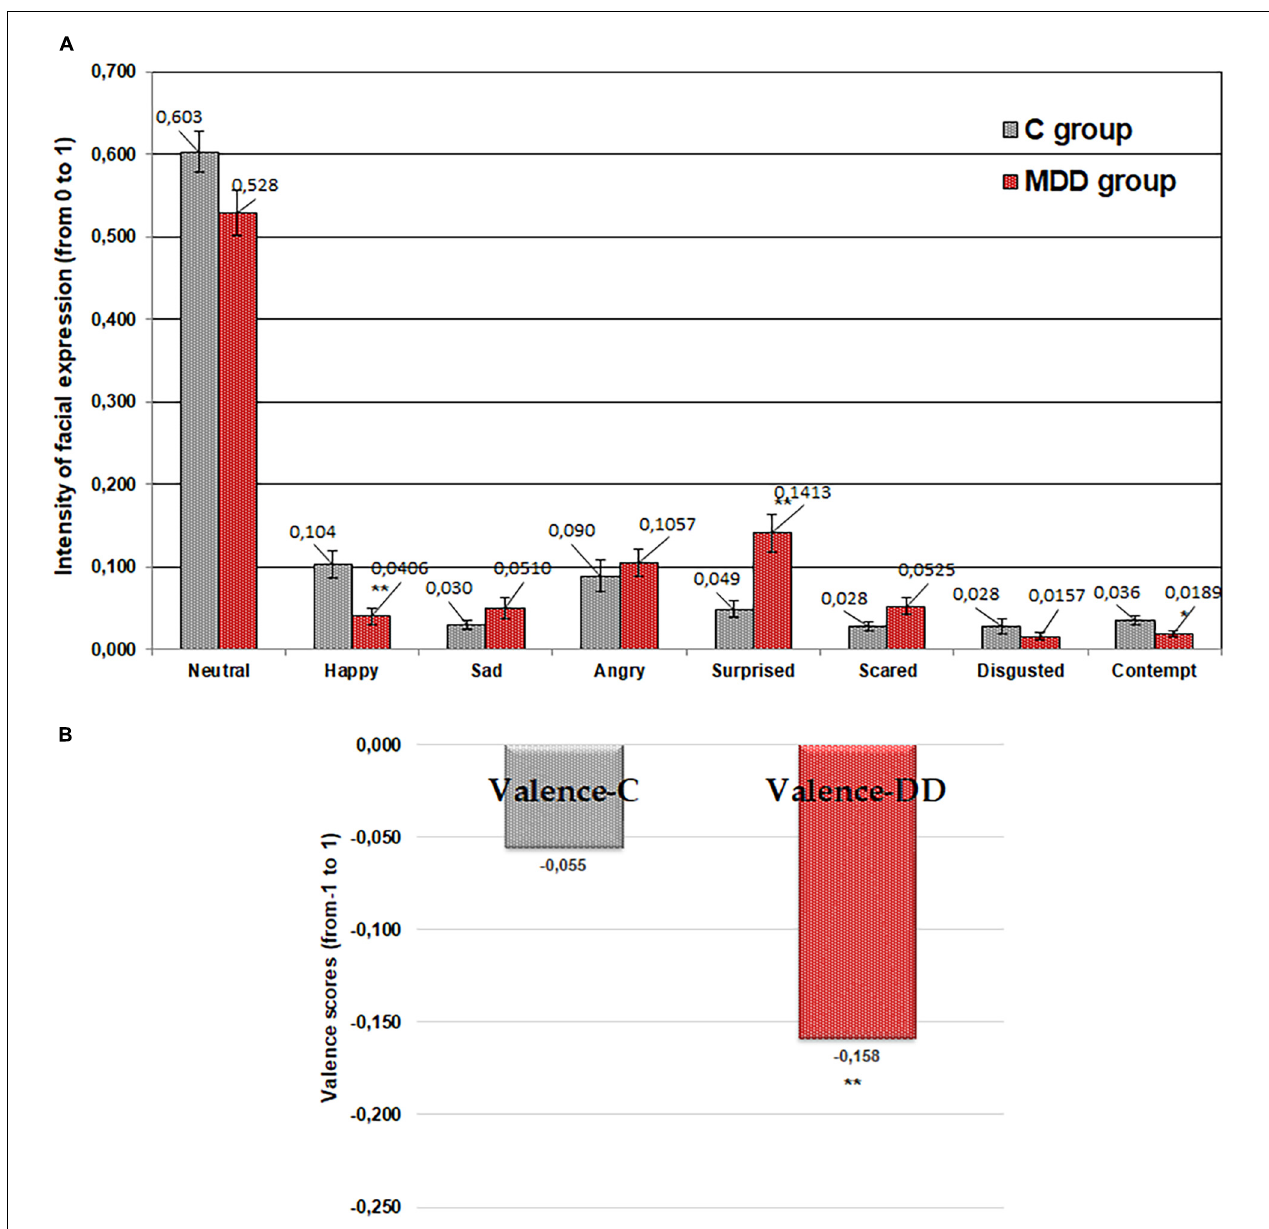
FIGURE 2 | Emotions (“neutral,” “happy,” “sad,” “angry,” “surprised,” “scared,” “disgusted,” and “contempt”) induced by imagined “sweet” tasting food (A) and valence (B) for patients with major depressive disorder (MDD group) and without MDD (C group). Significant difference between groups: *p ≤ 0.05; **p ≤